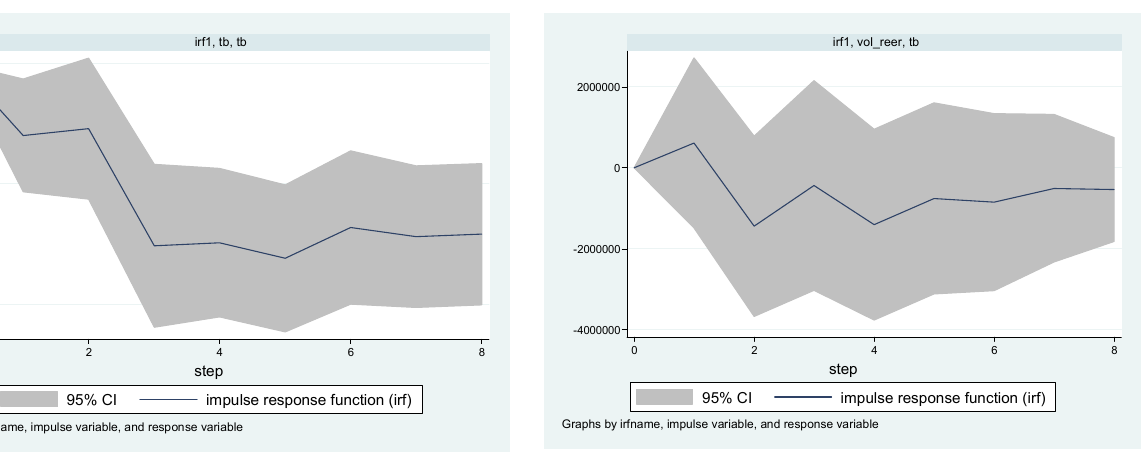
Fig. 3. The impulse response of the variable "vol_reer" to the variable